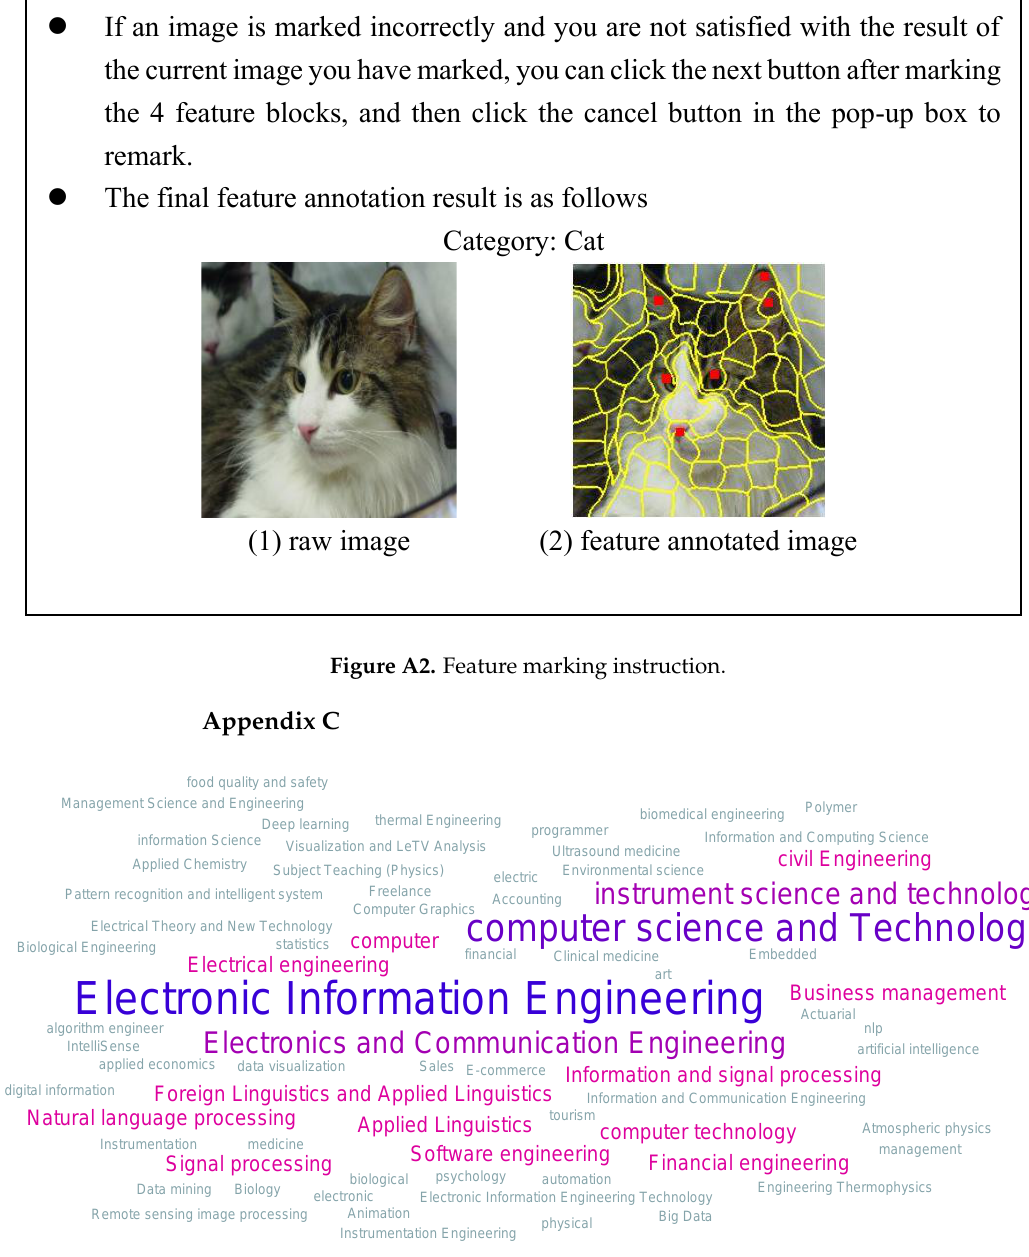
Figure A3. User major